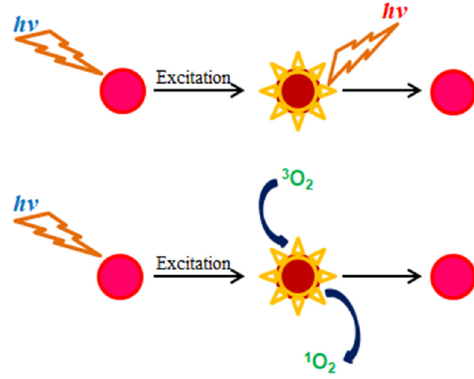
Scheme 2. Fluorescence quenching effect of oxygen-sensitive fluorescent porphyrin dye.